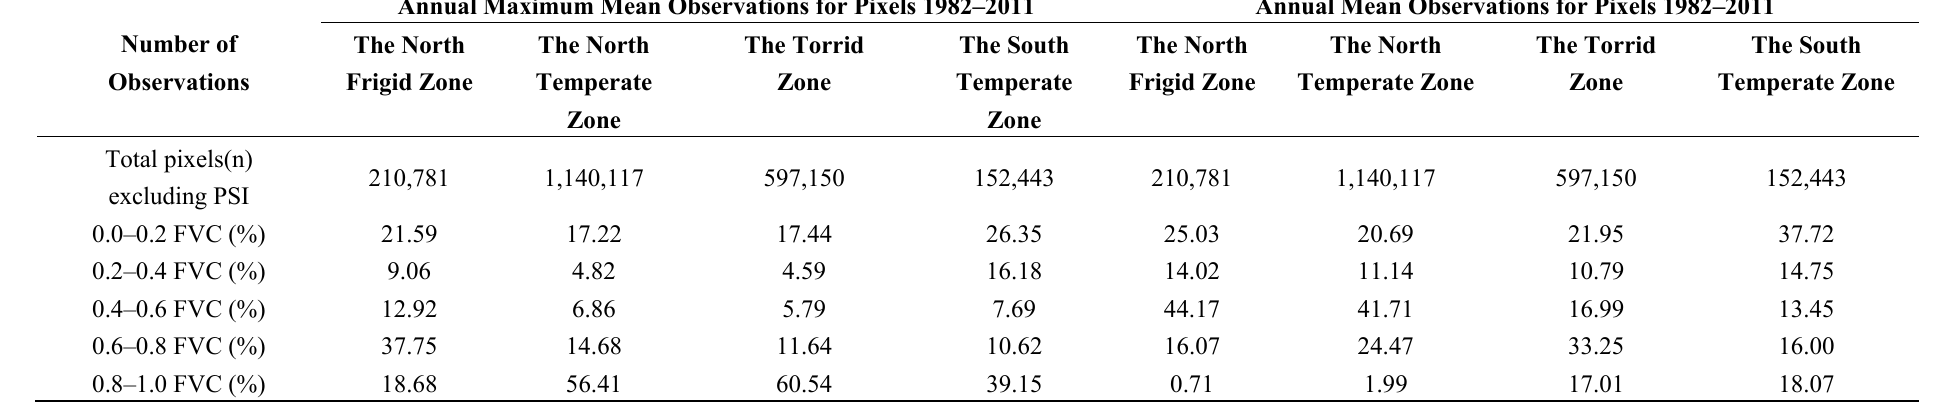
Table 3. Results for the average of the GIMMS FVC snow and ice with limited or no vegetation growth are masked (PSI, permanent snow and